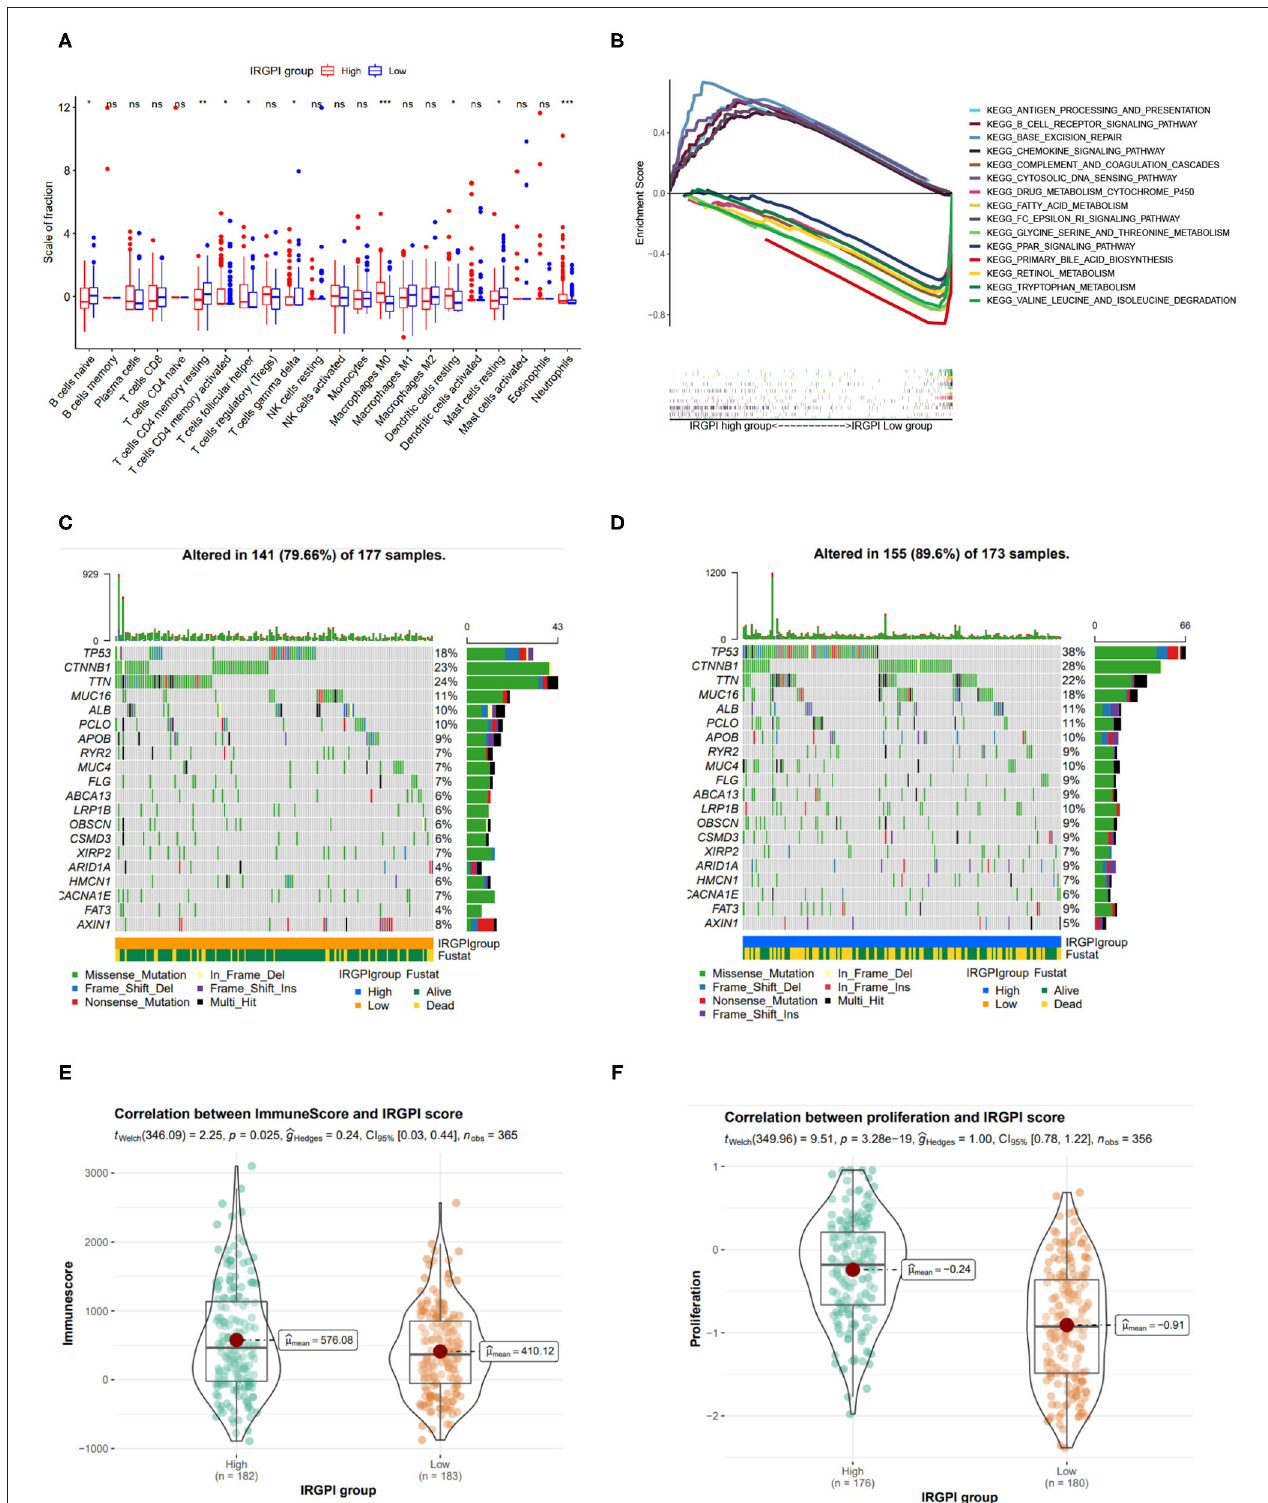
FIGURE 5 | Tumor immune environment, somatic mutation landscape, and immune scores between IRGPI low- and high-risk groups. (A) Comparison of tumor immune environment in two IRGPI groups. (B) Gene set enrichment analysis (GSEA) between two IRGPI groups. (C,D) Somatic mutation landscape between IRGPI low-risk and high-risk groups, respectively. (E) Difference of ESTIMATE immune score between two IGRPI groups. (F) Difference of proliferation score between two IGRPI groups.